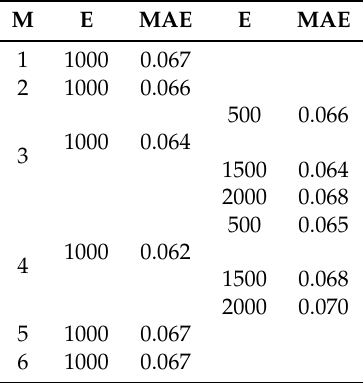
Table 3. Prediction performance of some configurations, L = 13 (MAE: Mean Absolute